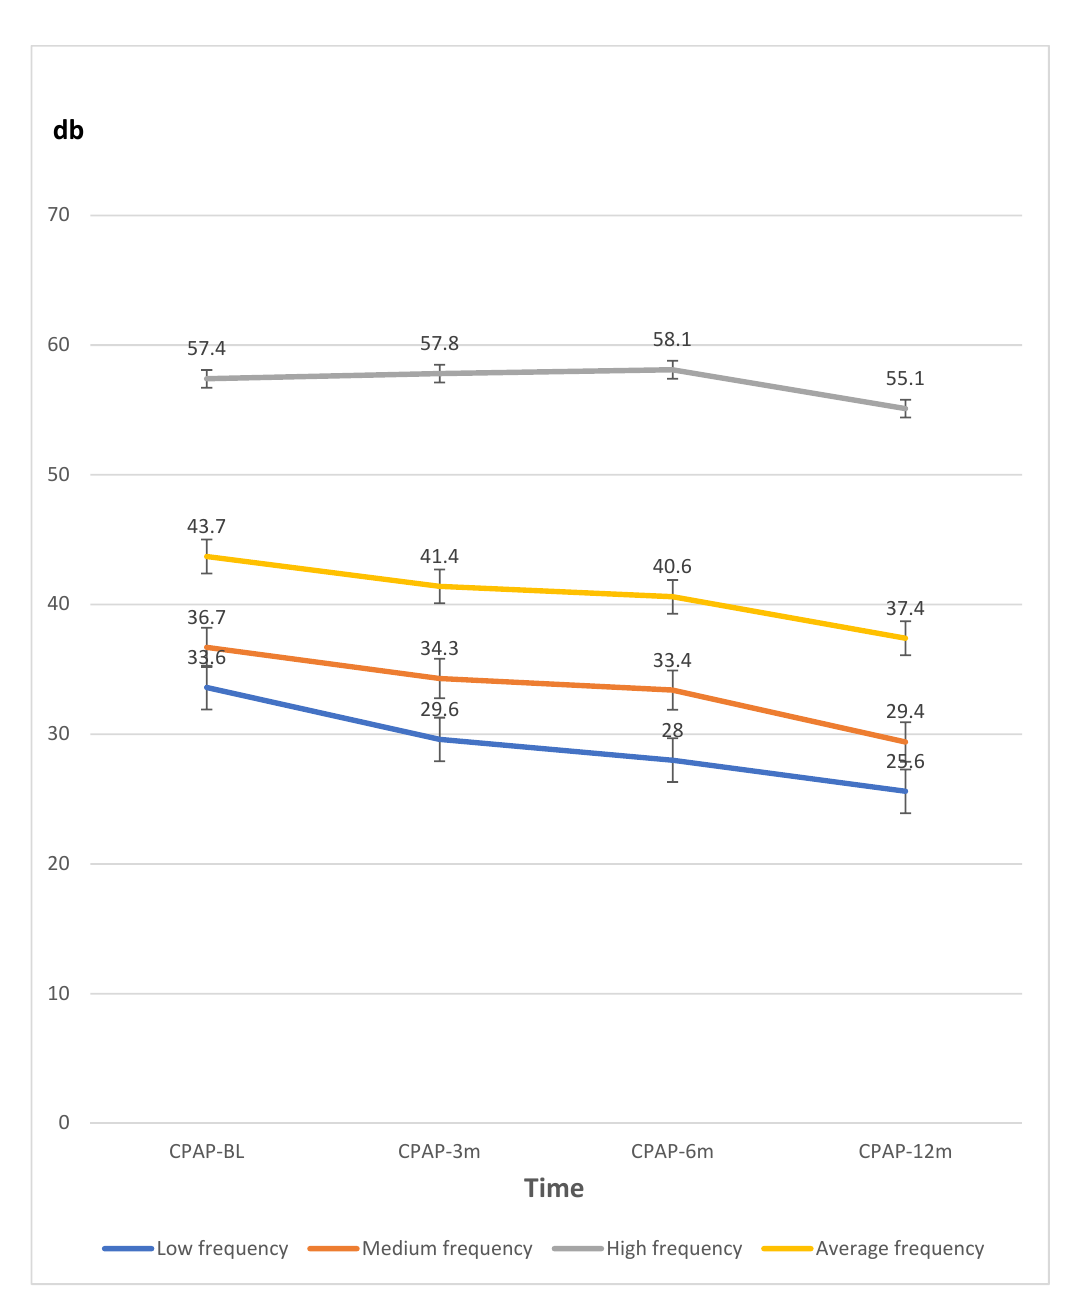
Figure 2. The line graph data of hearing thresholds by pure tone audiometry (dB) at various frequencies measured at baseline (BL), three (3 m), six (6 m), and 12 months (12 m) in the CPAP therapy group. Abbreviations : CPAP continuous positive airway pressure therapy; db, decibels.